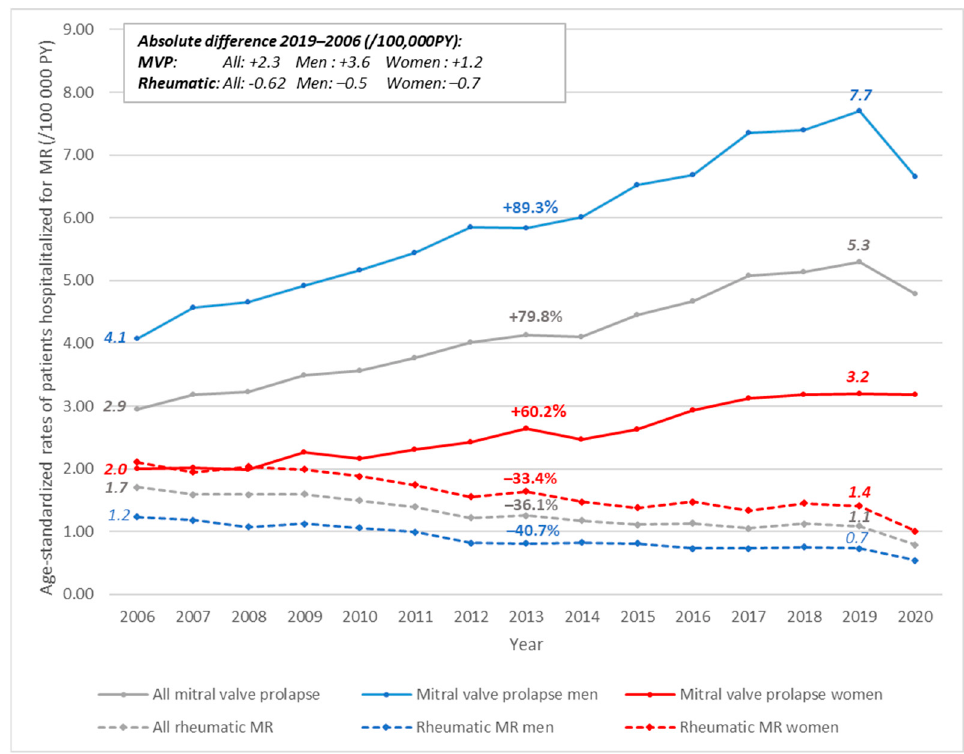
Figure 1. Trends in age-standardized rates of patients hospitalized for primary mitral regurgitation in person-years, according to etiology and sex, France, 2006–2020. The percentage above the curve is the relative rate difference between 2019 and 2006. PY = person-years; MVP = mitral valve prolapse.